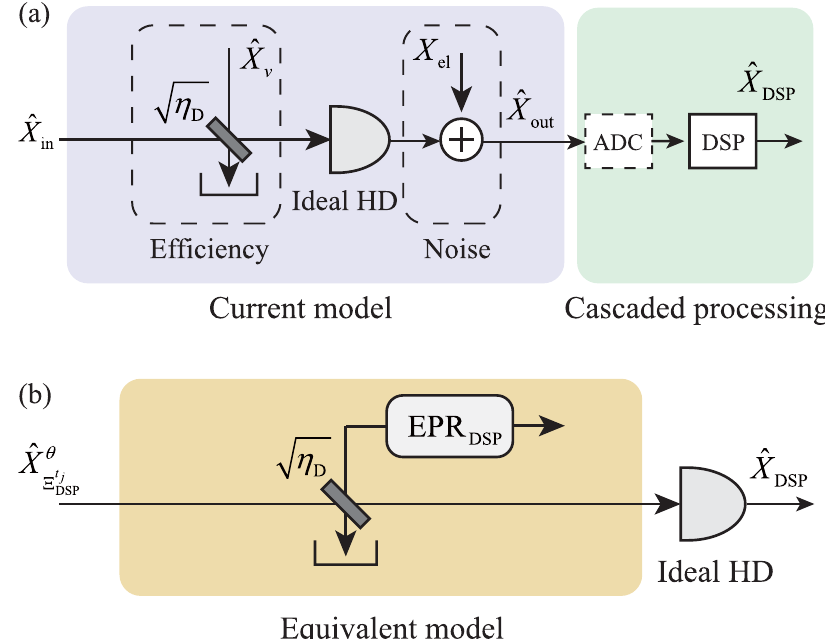
Fig. 4 The proposed detection model considering non-ideal ef fi ciency and electronic noise. a The PM version of our detection model. b The equivalent EB version of our detection